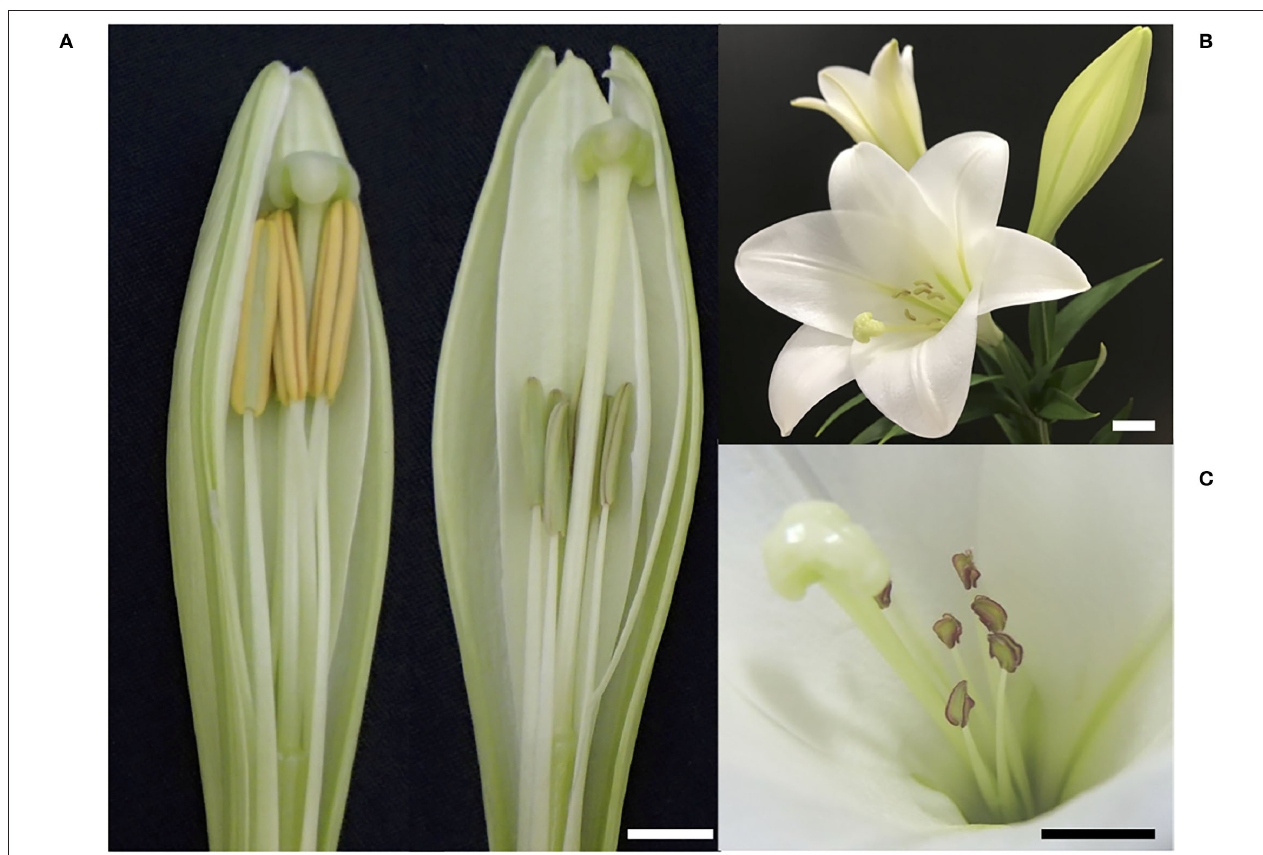
FIGURE 1 | Appearance of pollen-fertile and sterile L. × formolongi plants. (A) Flower buds of a pollen-fertile plant (left) and the pollen-sterile AR01 plant (right). (B) An opened flower of AR01. (C) Close up of sterile anthers of AR01. Bar = 1